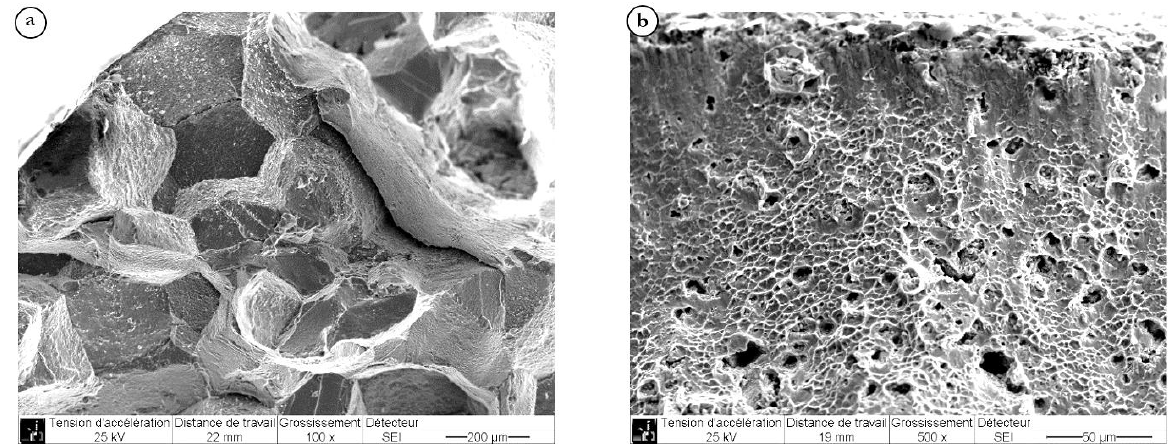
Figure 9. SEM fracture surface observations of crept specimens at 850 °C: ( a ) Coarse grains microstructure, 850 °C/250 MPa; ( b ) Fine grains microstructure, 850 °C/200 MPa.